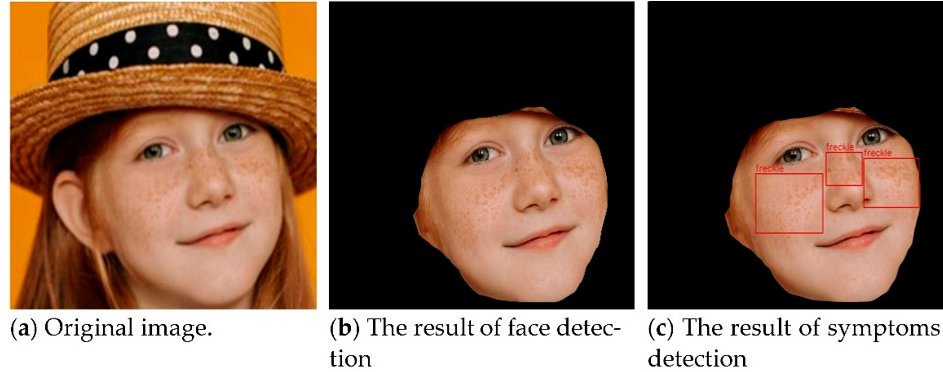
Figure 7. The results of detect symptoms